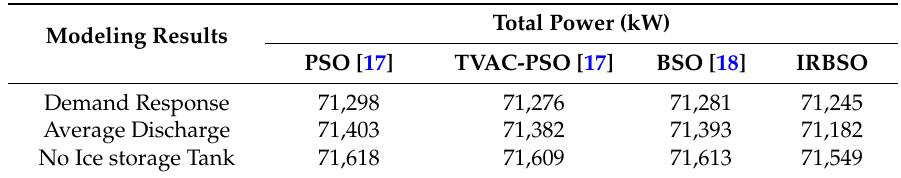
Table 8. Power load for dynamic electricity price in case study.